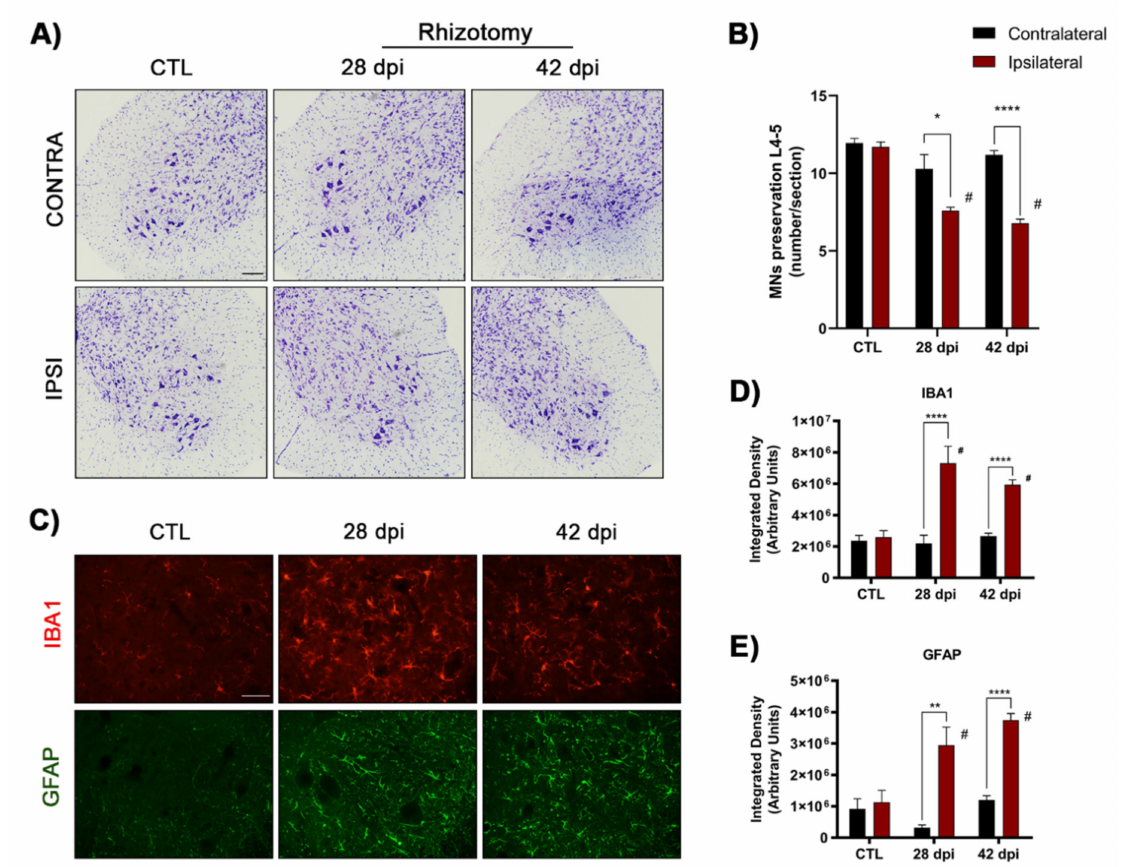
Figure 2. MN death and glial cell activation after rhizotomy. ( A ) Representative images of cresyl violet staining corre- sponding to ventral horns of L4–L5 spinal segments of the contra- and ipsilateral side to L4–L5 rhizotomy in control and in rhizotomized mice at 28 and 42 dpi. Scale bar 100 µ m. ( B ) Plot of number of surviving α -MNs in L4–L5 segments, showing a decrease of MNs in the ipsilateral side to the injury; n = 4 female mice at 28 dpi and n = 14–16 animals at 42 dpi. ( C ) Images of immunolabeled microglia (Iba1) and astrocytes (GFAP) in the ipsilateral ventral horn of lumbar spinal cord. Scale bar 50 µ m. ( D , E ) Plots of the integrated density of Iba-1 ( D ) and GFAP ( E ) immunoreactivity in the ventral horn of the spinal cord. Rhizotomy caused a significant increase of astrocyte and microglial reactivity. n = 3–6 mice per day and group. Data are mean ± SEM. Two-way ANOVA and Bonferroni post-hoc test; * p < 0.05, ** p < 0.01, **** p < 0.0001 vs. the contralateral side; # p < 0.05 vs. control intact